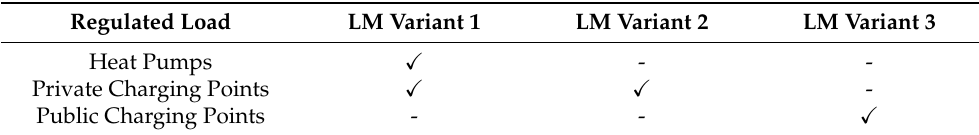
Table 3. Overview of the regulated load for each of the three load management variants (“ (cid:88) ”: regulated, “-”: not